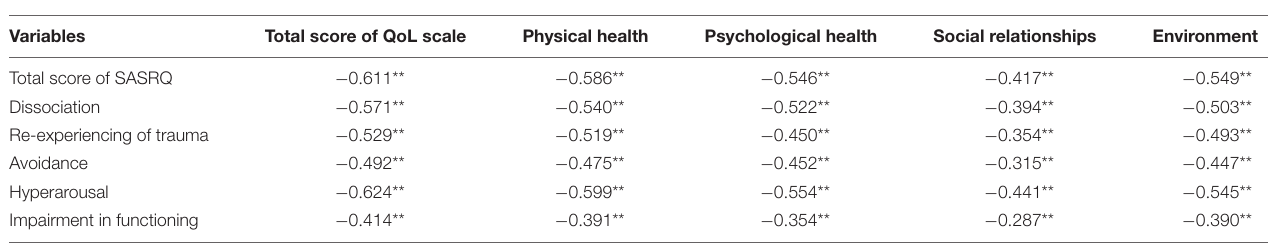
hierarchical steps. Table 4 shows the results of the final multiple linear regression model. In our study, falling between 35